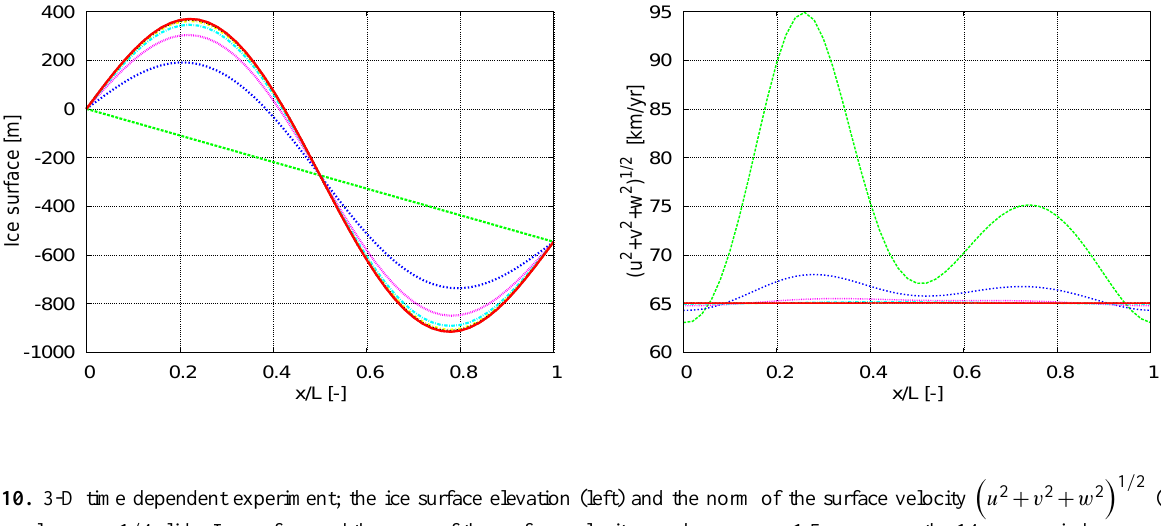
Fig. 9. 3-D time-dependent experiment. The graphs show the the norm of the velocity beginning (left) and at the time when the steady-state is reached (right). At the beginning, velocity has two local maximums, over the bump and over the bed where the bed changes the most. At the steady-state position, velocity is spatially uniform and proportional to the ice thickness.